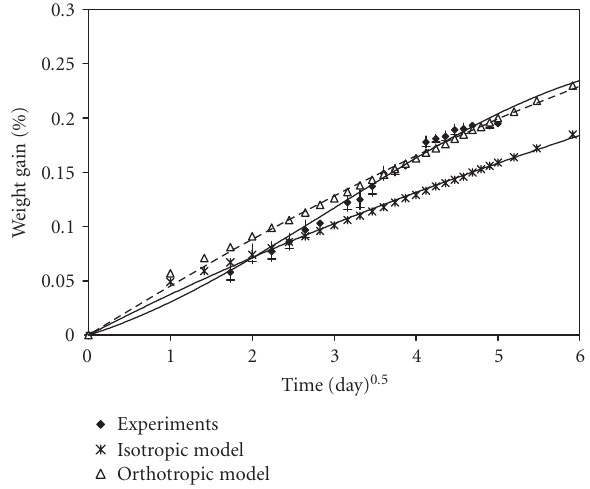
Figure 16: Numerical and experimental results of relative weight gain as a function of